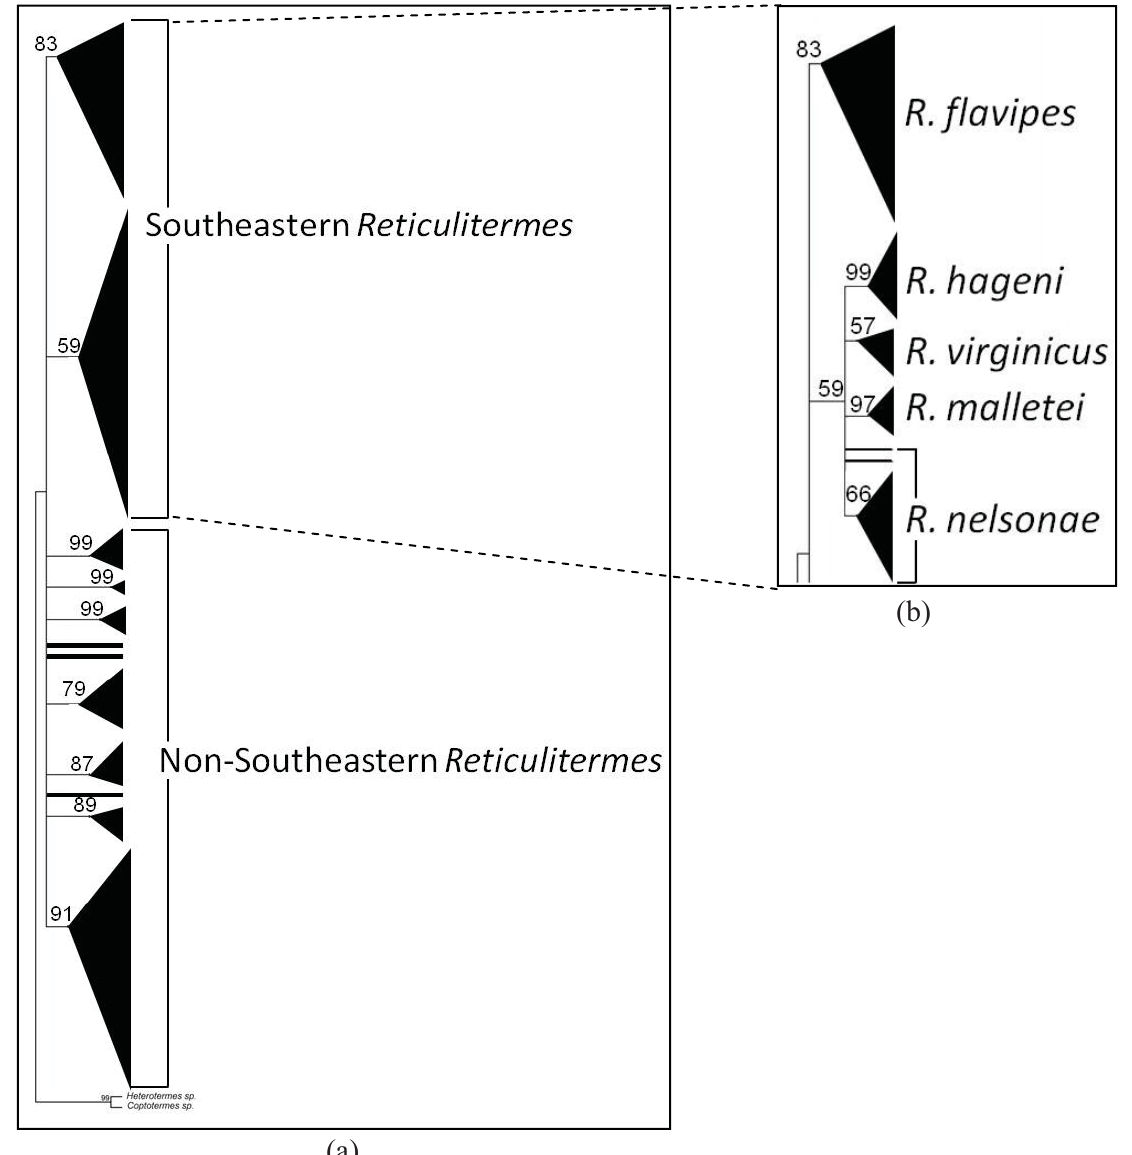
Figure 5. Maximum parsimony (MP) estimate of the Reticulitermes phylogeny based